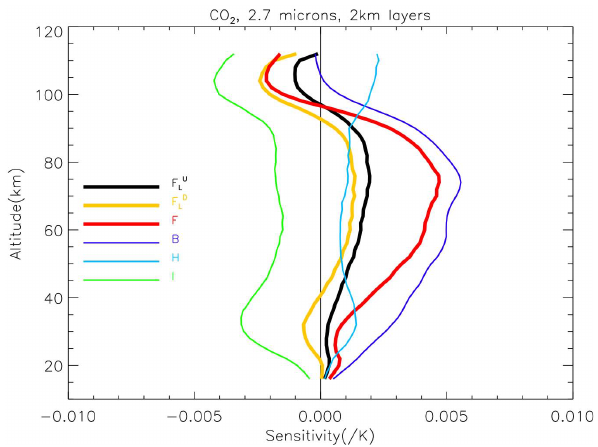
Fig. 6. Same as Fig. 5 but using only the weaker part of the P-branch of the O 2